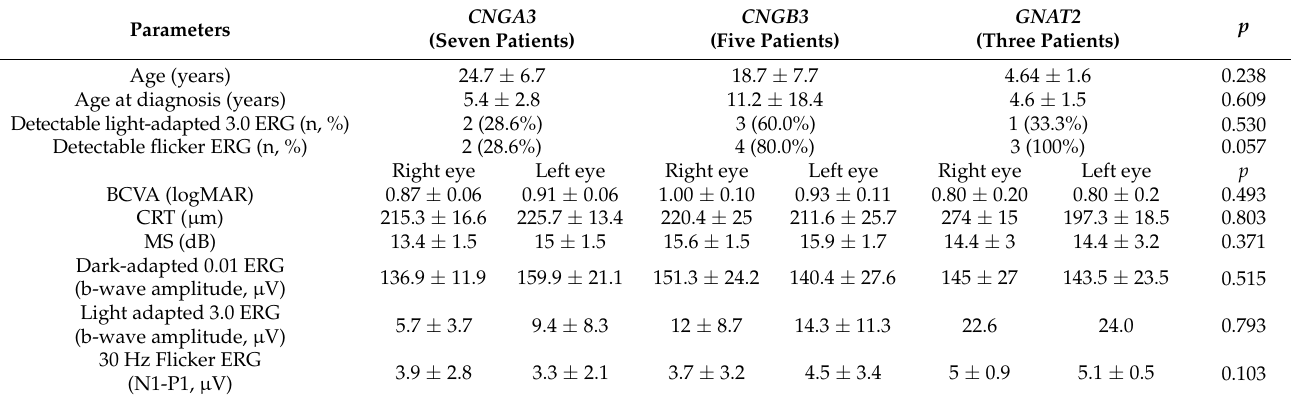
Table 4. Comparison of ACHM patients stratified according to the